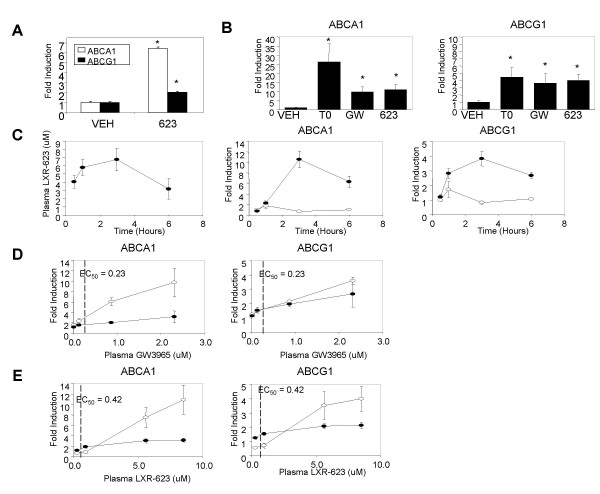
LXR agonists increase ABCA1 and ABCG1 mRNA levels in rat peripheral blood cells. (A) Normal C57/Bl6 mice on normal chow were orally dosed with a single administration of 50 mg/kg LXR-623 (623) or vehicle (VEH). At 4 hours post-dosing, peripheral blood expression of ABCA1 and ABCG1 mRNA was quantified by real-time PCR, using GAPDH as the normalizer. The bars indicate the normalized mean transcript levels +/- SEM (n = 4 per group). (B) Male Long Evans rats were administered a single dose of 10 mg/kg T0901317 (T0), 30 mg/kg GW3965 (GW), 30 mg/kg LXR-623 (623) or vehicle (VEH) by oral gavage. Three hours later peripheral blood expression of ABCA1 and ABCG1 mRNA was quantified by real-time PCR (100 ng RNA/assay). All expression values were normalized for GAPDH mRNA, with the level of expression in rats treated with vehicle defined as 1.0. Values are the mean +/- SEM (n = 6 per group). (C) Male Long Evans rats were administered a single dose of vehicle (open circles) or 30 mg/kg LXR-623 (filled circles) by oral gavage. At the indicated time points plasma concentration of LXR-623 (uM) and peripheral blood cell expression of ABCA1 and ABCG1 were determined. Values are the mean +/- SEM (n = 6 per group). (D) Male Long Evans rats were administered a range (0.01 to 30 mg/kg) of GW3965 by oral gavage. Three hours later plasma GW3965 concentration, peripheral blood ABCA1 and ABCG1 expression, and spleen ABCA1 and ABCG1 expression were quantified. The induction of gene expression in the peripheral blood (open circles) and spleen (filled circles) is plotted as a function of the plasma drug concentration. The EC50 for GW3965 induction of ABCA1 expression in murine J774 macrophages is denoted for reference. Values are the mean +/- SEM (n = 6 per group). (E) As above, except that rats were treated with a range (1 to 30 mg/kg) of LXR-623. * p < 0.01 compared to vehicle treatment, as determined by Student's t test.